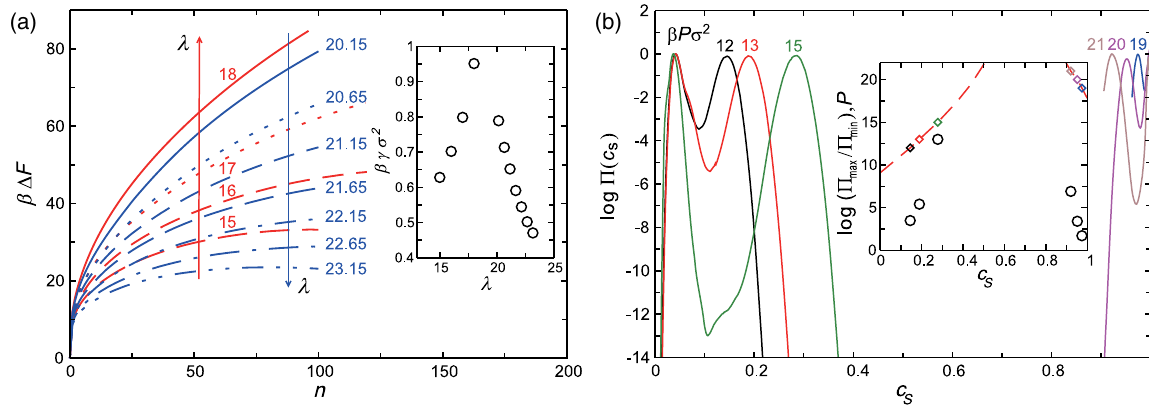
FIG. 3. Free-energy barriers and interface tension. (a) Free-energy barriers for the SW model as a function of nucleus size n , β Δ F ð n Þ , for the formation of the bcc crystal (red lines) and the dc crystal (blue lines) for state points at constant thermodynamic driving force, β Δ μ ¼ 0 . 6 . The system size for these simulations is N ¼ 4000 particles. The inset shows βγσ 2 extracted from the fit of the free-energy barrier with the CNT expression: β Δ F ð R Þ ¼ j β Δ μ j 4 πρ R 3 = 3 þ βγ 4 π R 2 , where R is the radius of the nucleus [ R ¼ ð 3 n= 4 πρ Þ 1 = 3 for a spherical nucleus], j β Δ μ j ¼ 0 . 6 . (b) Order parameter probability distribution functions Π ð c for the BD system at coexistence at S Þ different pressures, P ¼ 12 , 13, 15 for the L crystal and P ¼ 19 , 20, 21 for the S crystal. The inset shows the height of the barrier (circles) as a function of concentration c , which is directly proportional to the line tension. Also plotted are the liquidus line (dashed red S line) and the state points (diamond symbols) at which Π ð c is calculated (notice that, in this case, the y -axis represents pressures). S Þ 1 and β ¼ 1 Pressure is in adimensional units with σ L ¼